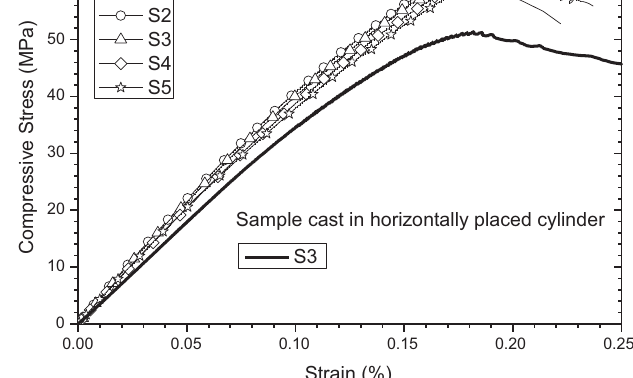
Reference concrete samples